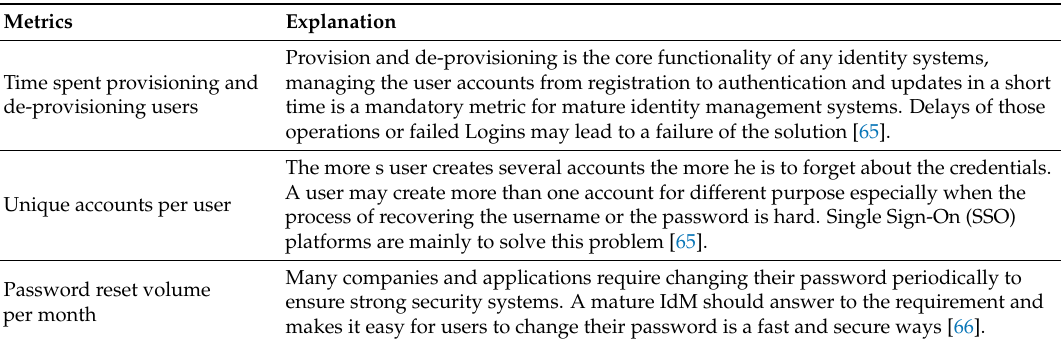
Table 6. Blockchain-based identity management systems